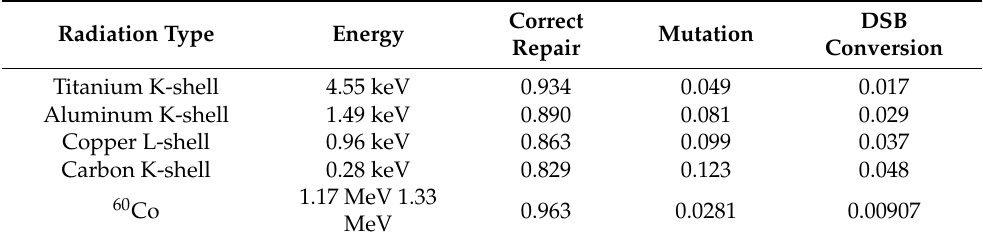
Table 5. Average repair outcome probabilities for all types of DNA damage for cells irradiated with ultrasoft X-rays or 60 Co γ -rays. Radiation Type Energy